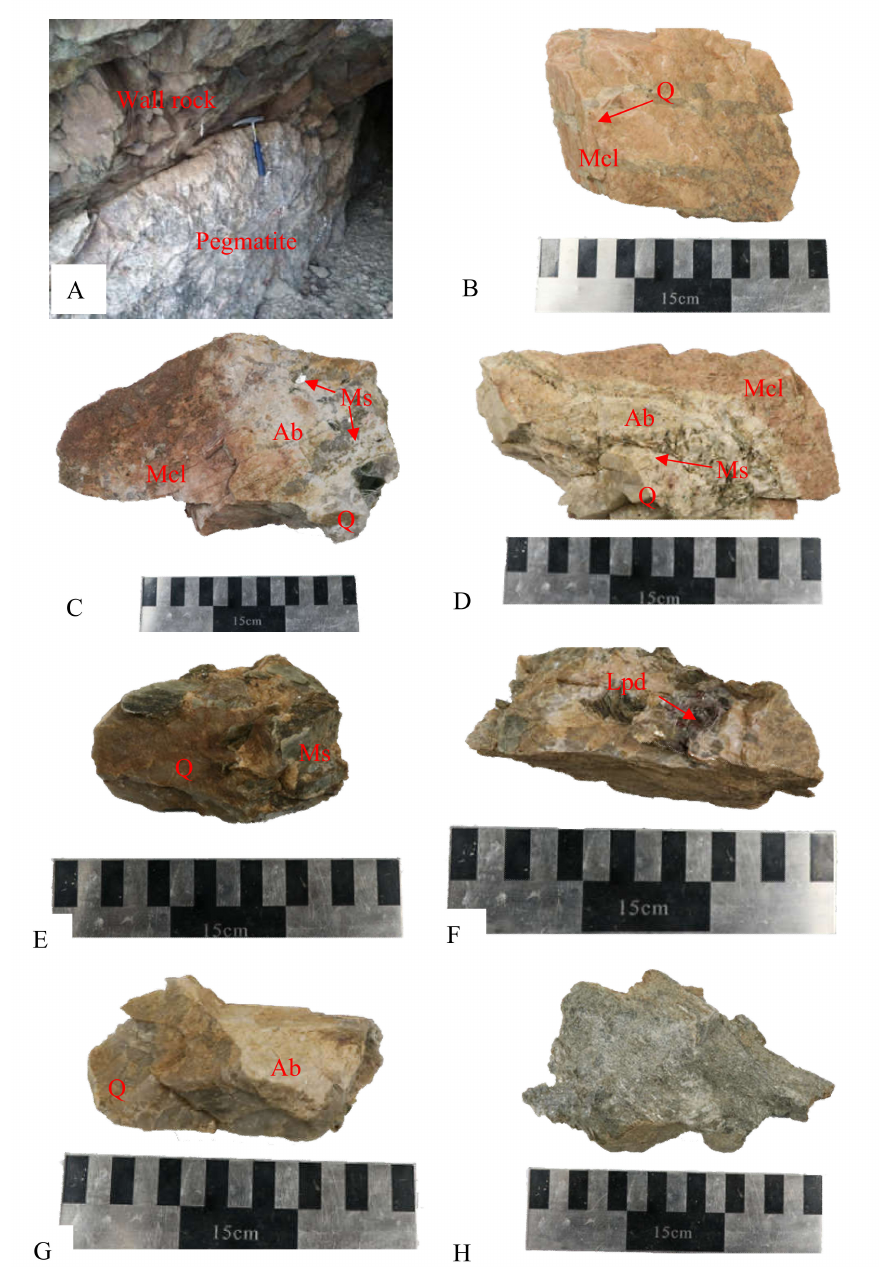
Figure 3. Field occurrence of pegmatites in the Lijiapuzi Nb-Ta ore deposit. ( A ) An abandoned mining gallery; ( B ) Marginal microcline rock sample, with late quartz veinlets filled in the fractures; ( C , D ) Transitional albite rock sample, with gradual or irregular boundary; ( E ) Sample close to quartz core, with greenish muscovite; ( F ) purple lepidolite; ( G ) quartz core; ( H ) Chloritized plagioclase amphibolite; Mcl-microcline; Q-quartz; Ab-albite; Ms-muscovite;